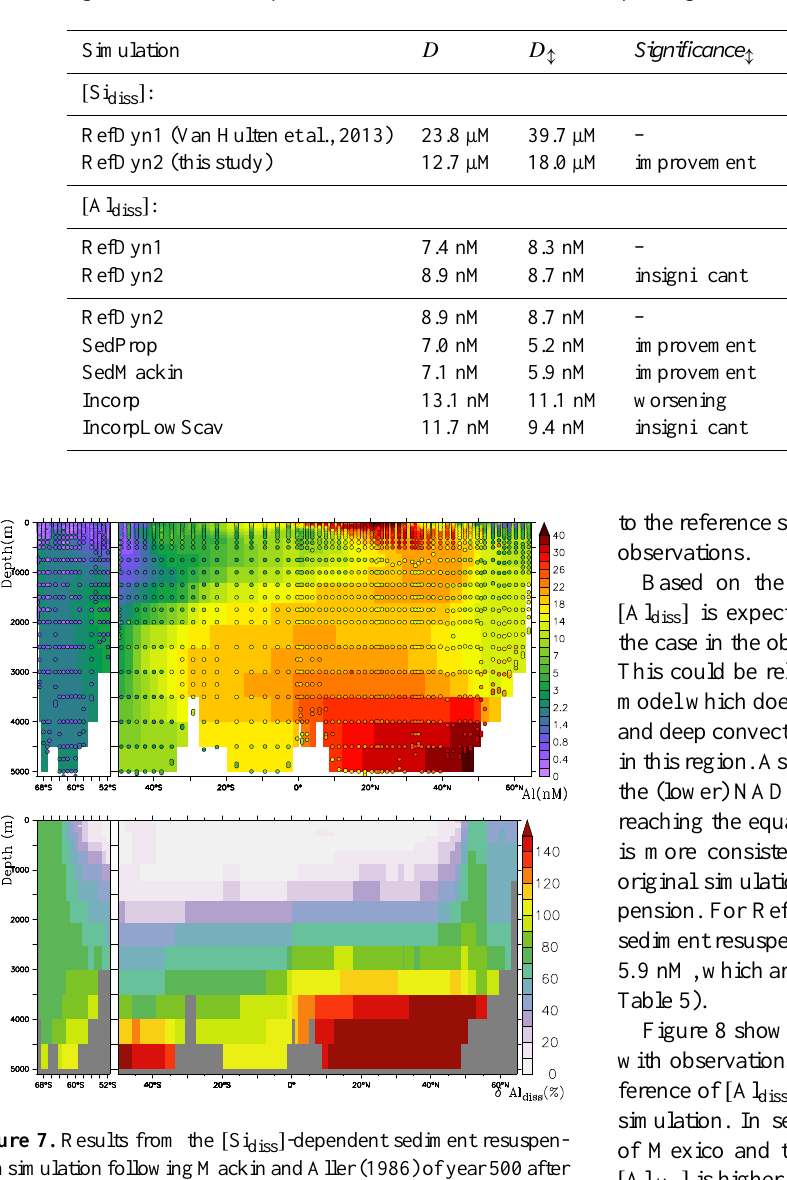
Table 5. Statistics of [ Si diss ] (first two rows) and [ Al diss ] (other rows) of the simulations in the West Atlantic GEOTRACES transect. Here D is the unweighted RMSD, D l the vertically homogenised RMSD (accompanied with its significance compared with D l from the first row of each subtable, and the 2 σ range), r is the correlation coefficient, RI the reliability index and RI l is the vertically homogenised reliability index. The significance is with respect to the first simulation in the corresponding subtable.